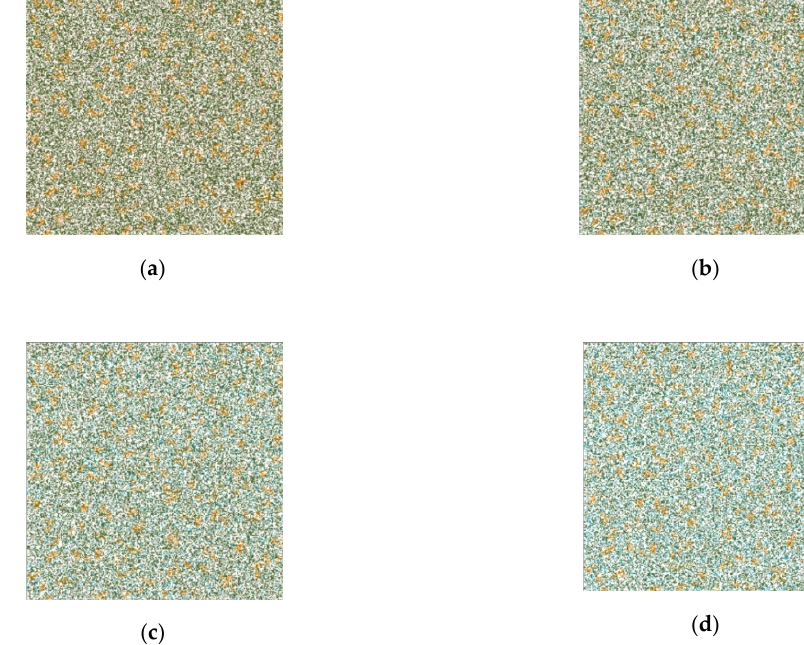
Figure 8. Catalytic reaction cellular automata evolution (( a – d ) correspond different moments of time), two-dimensional slice. Field size—300 × 300 cells, orange cells—catalyst, green—aniline, pink—formaldehyde, blue—product.